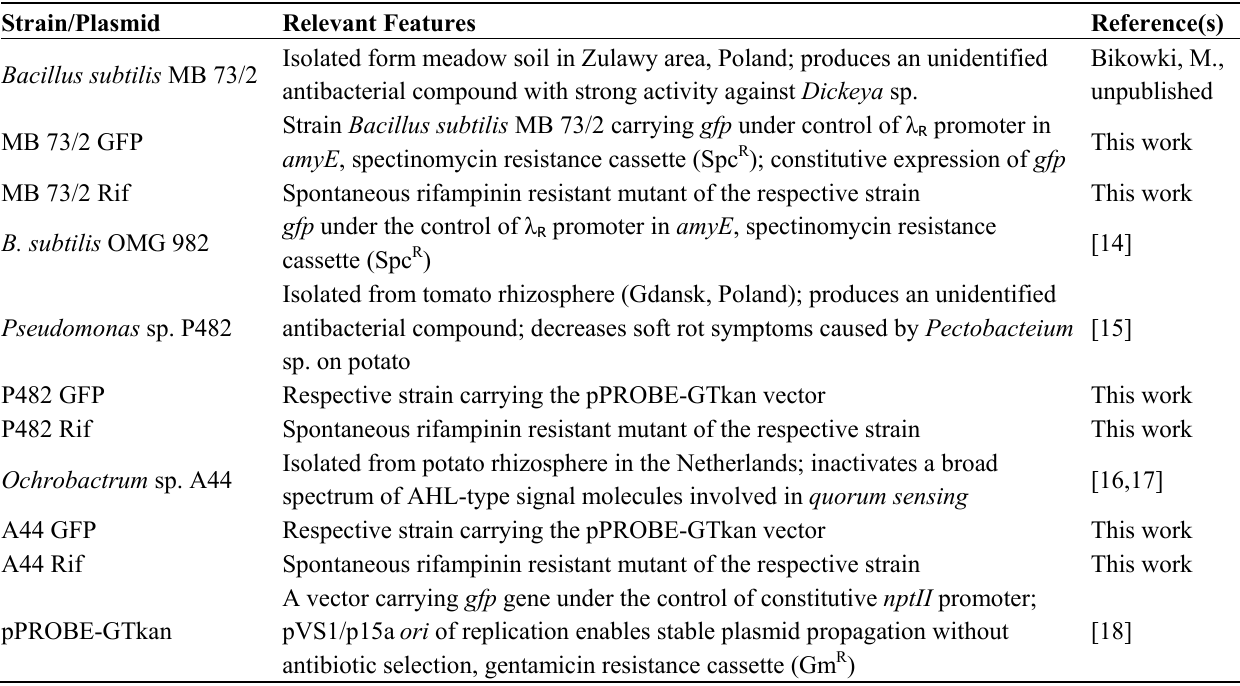
Table 1. Bacterial strains and plasmids used in this